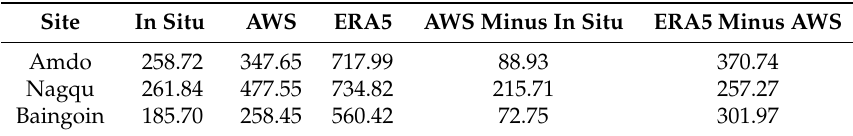
Figure 2. The accumulated precipitation (mm) from di ff erent datasets from 1 August 2014 to 1 August 2015 at the ( a ) Amdo site, ( b ) Nagqu site, and ( c ) Baingoin site. (AWS: precipitation from auto weather station; in situ: precipitation from in situ measurements; ERA5: precipitation from ECMWF reanalysis dataset ERA5). Table 1. The annual total precipitation in di ff erent datasets and the di ff erence between di ff erent datasets (unit: